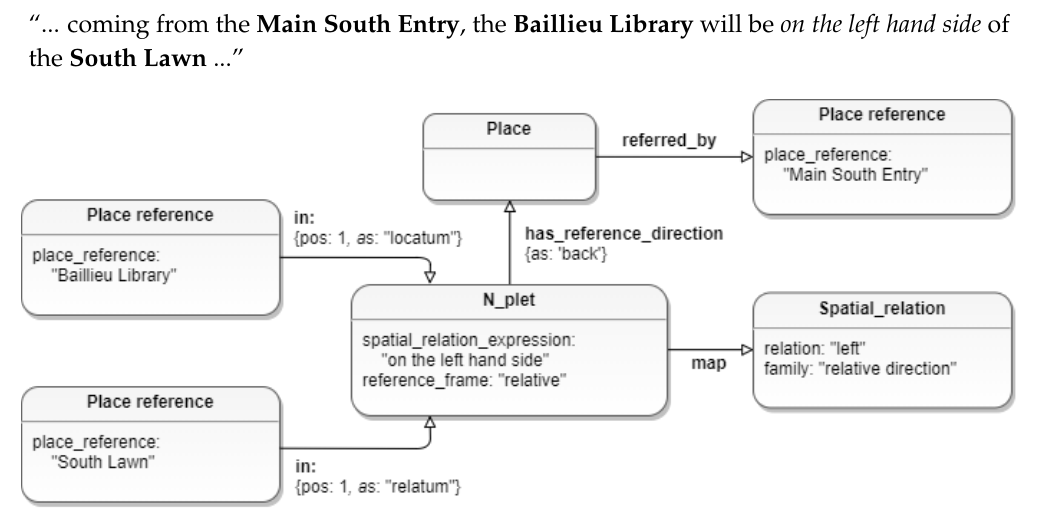
Figure 5. An example of modelling a relative direction relationship using the extended place